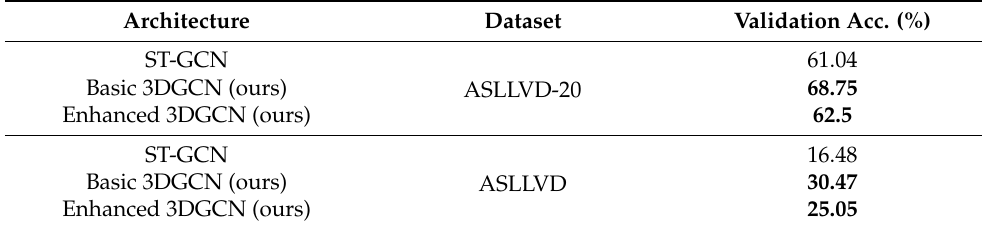
Table 4. Performance comparison on the ASLLVD